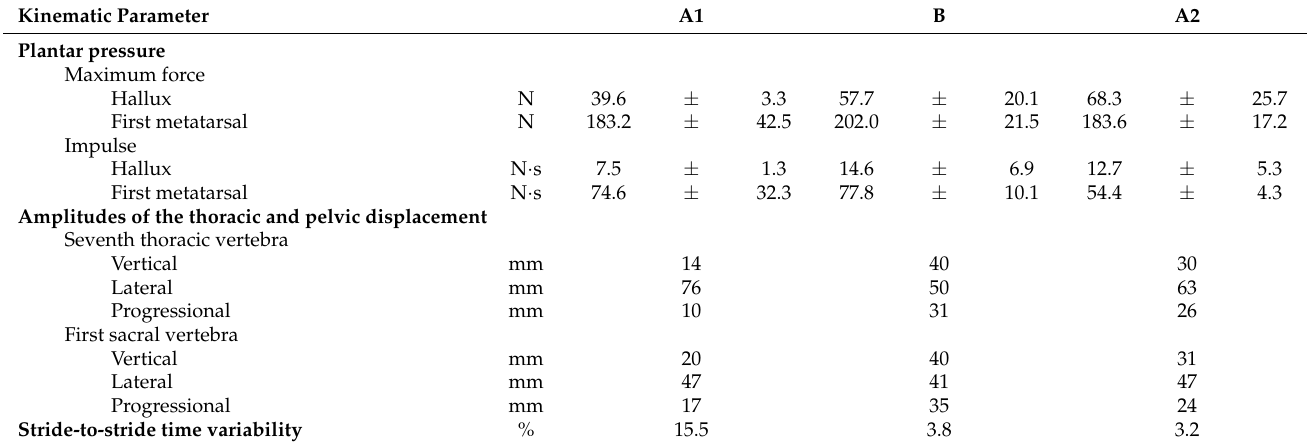
Table 1. Serial changes in kinematic parameters during